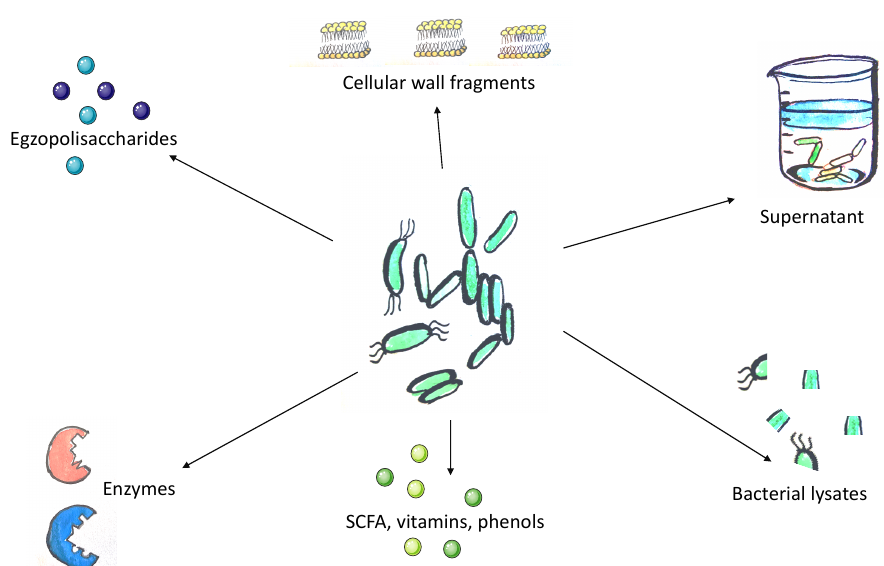
Figure 2. Methods of acquisition of postbiotics. The concept of postbiotics conceals either metabolites or fragments of microorganisms which confer a beneficial effect to the host. The structural heterogeneity of postbiotics implies the abundance of possible techniques used to postbiotics’ acquisition. Lysis of bacterial cells may be achieved by chemical and mechanical techniques. These methods include enzymatic extraction, solvent extraction, sonication, and heat. Extraction, dialysis, and chromatography are used to isolate and identify desired molecules. SCFA, short-chain fatty acids